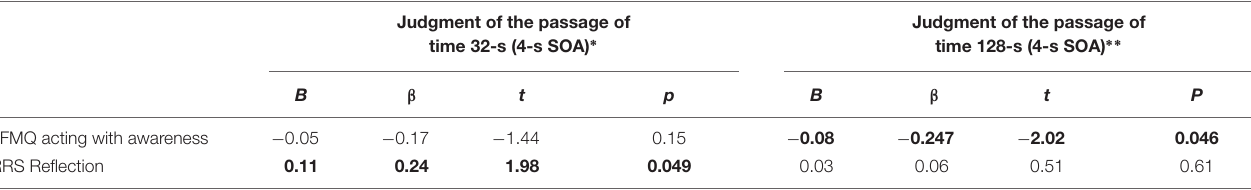
TABLE 5 | Multiple linear regression analysis between judgment of the passage of time (4-s SOA conditions) and significant psychological dimensions.